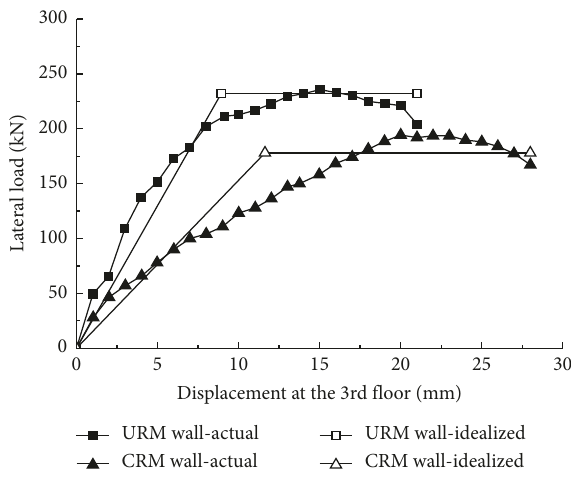
Figure 13: Actual and idealized envelop curves.